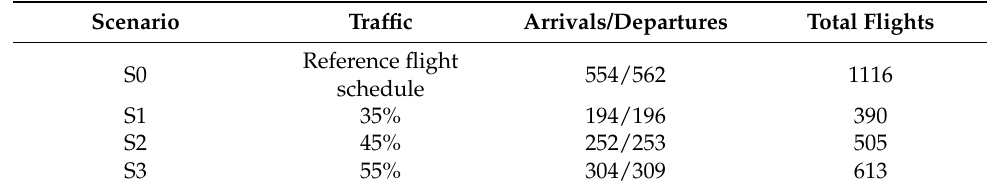
Table 3. Amount of flights for the reference flight schedule and for the three recovery scenarios.